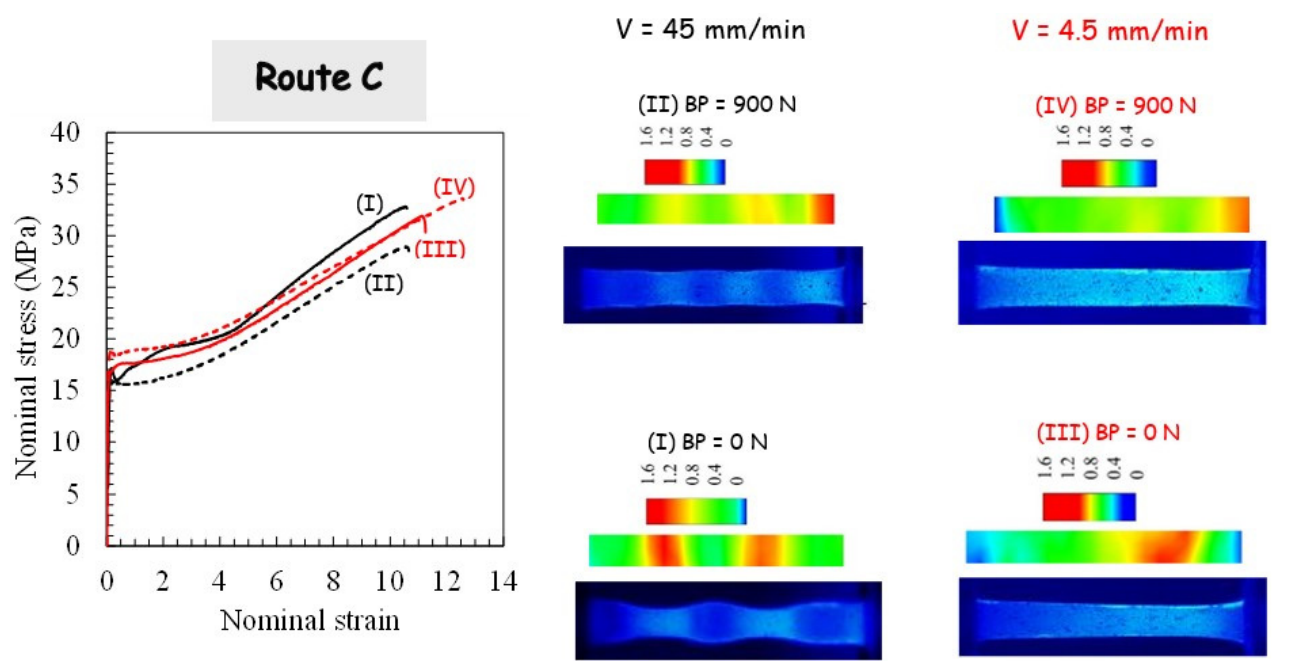
Figure 10. Tensile results after second pass extrusion in route C in terms of stress-strain curve, deformation behavior and strain localization for different processing parameters: ( I ) ram velocity of 45 mm/min and BP of 0 N, ( II ) ram velocity of 45 mm/min and BP of 900 N, ( III ) ram velocity of 4.5 mm/min and BP of 0 N, and ( IV ) ram velocity of 4.5 mm/min and BP of 900 N.